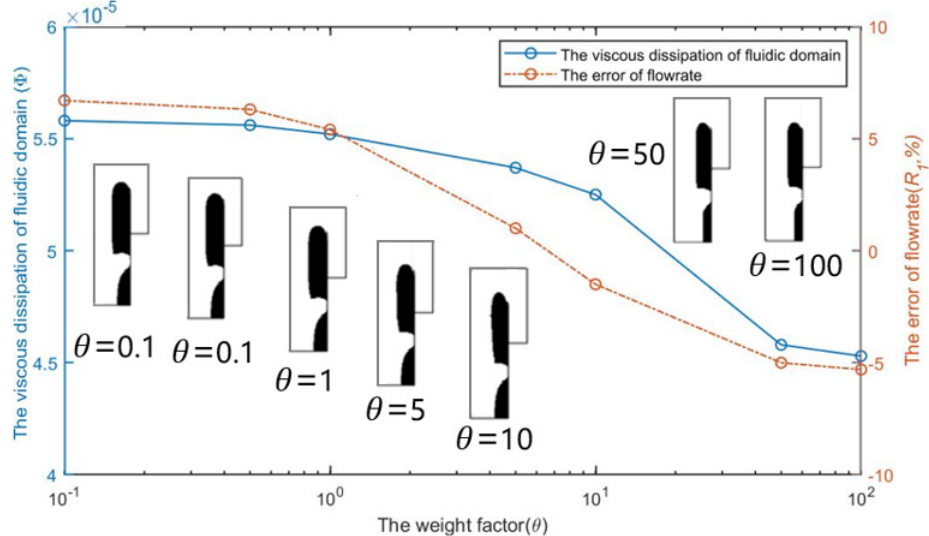
Figure 5. The optimization results and the effect of the weight coefficient 𝜃 on the error 𝑅 (cid:2869) of Φ of fluidic flowrates and the viscous dissipation Φ of fluidic domain. flowrates and the viscous dissipation